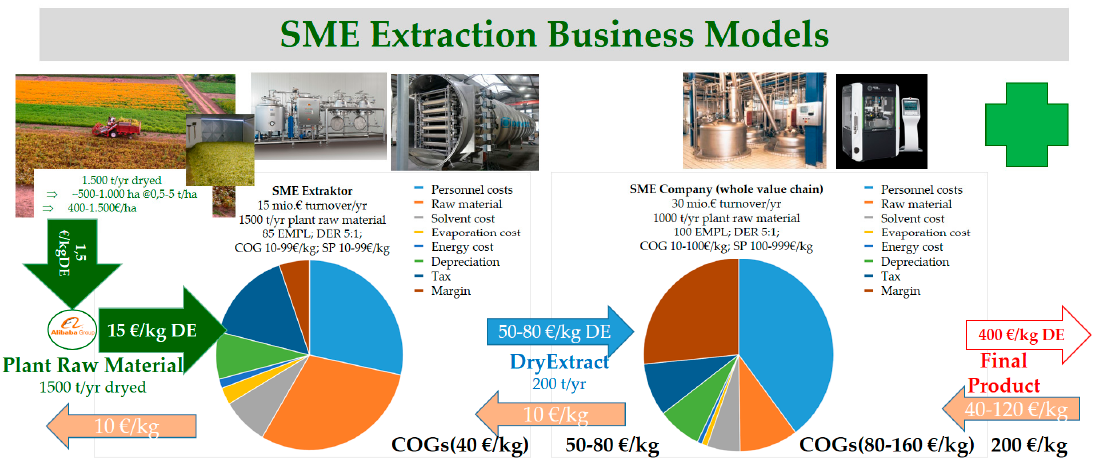
Figure 1 . Business models along the value chain: cultivation, extraction, formulation and sales. DE, dry extract; SME, small and medium enterprises; EMPL, employee; DER, drug extract ratio; COG, cost of goods; SP, selling price.